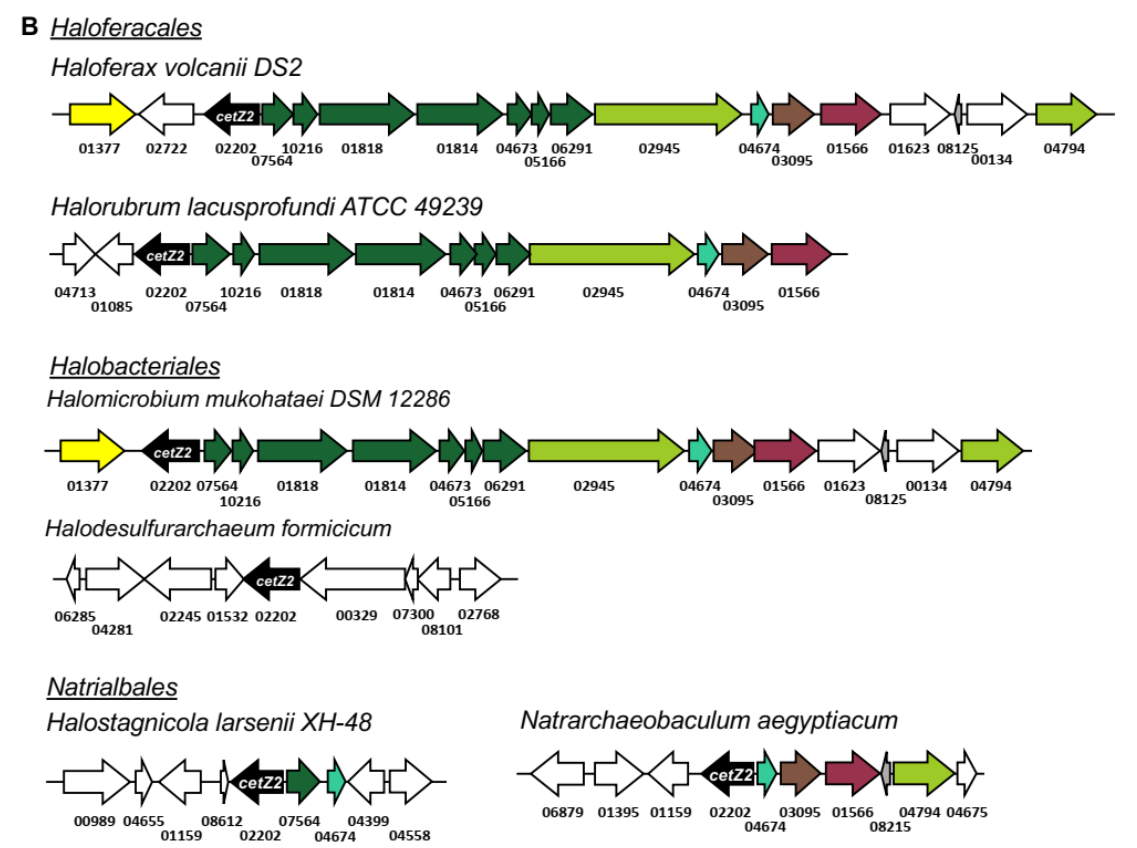
Figure 6. Conserved portions of pili-associated and non-pili-associated cetZ2 genomic regions in Halobacteria. ( A ) The 20 kb regions either side of the cetZ2 gene were analysed from 22 species of the orders Haloferacales (10), Halobacteriales (7), and Natrialbales (5). Of these 22 regions, 12 were pili-associated and 10 were non-pili-associated. Table listing the most frequently observed arCOGs and their occurrence in 22 cetZ2 genomic regions from the orders Haloferacales, Halobacteriales, and Natrialbales. ( B ) Examples of cetZ2 genomic regions, showing their conserved residues only. The cetZ2 regions from Haloferax volcanii DS2 , Halorubrum lacusprofundi ATCC 49239 , and Halomicrobium mukohataei DSM 12286 are pili-associated. The cetZ2 regions from Halodesulfurarchaeum formicicum , Halostagnicola larsenii XH-48 , and Natrarchaeobaculum aegyptiacum are non-pili associated. Genes encoding cetZ2 are represented in black, and genes belonging to arCOGs present within majority (at least 11) of the cetZ2 genomic regions are coloured according to their COG category as detailed in Table S2. arCOGIDs are listed beneath each gene. arCOGs encoding uncharacterised proteins which are present in at least half of the cetZ2 genomic regions are represented in grey, and arCOGs not present in majority of cetZ2 genomic regions are represented in white.